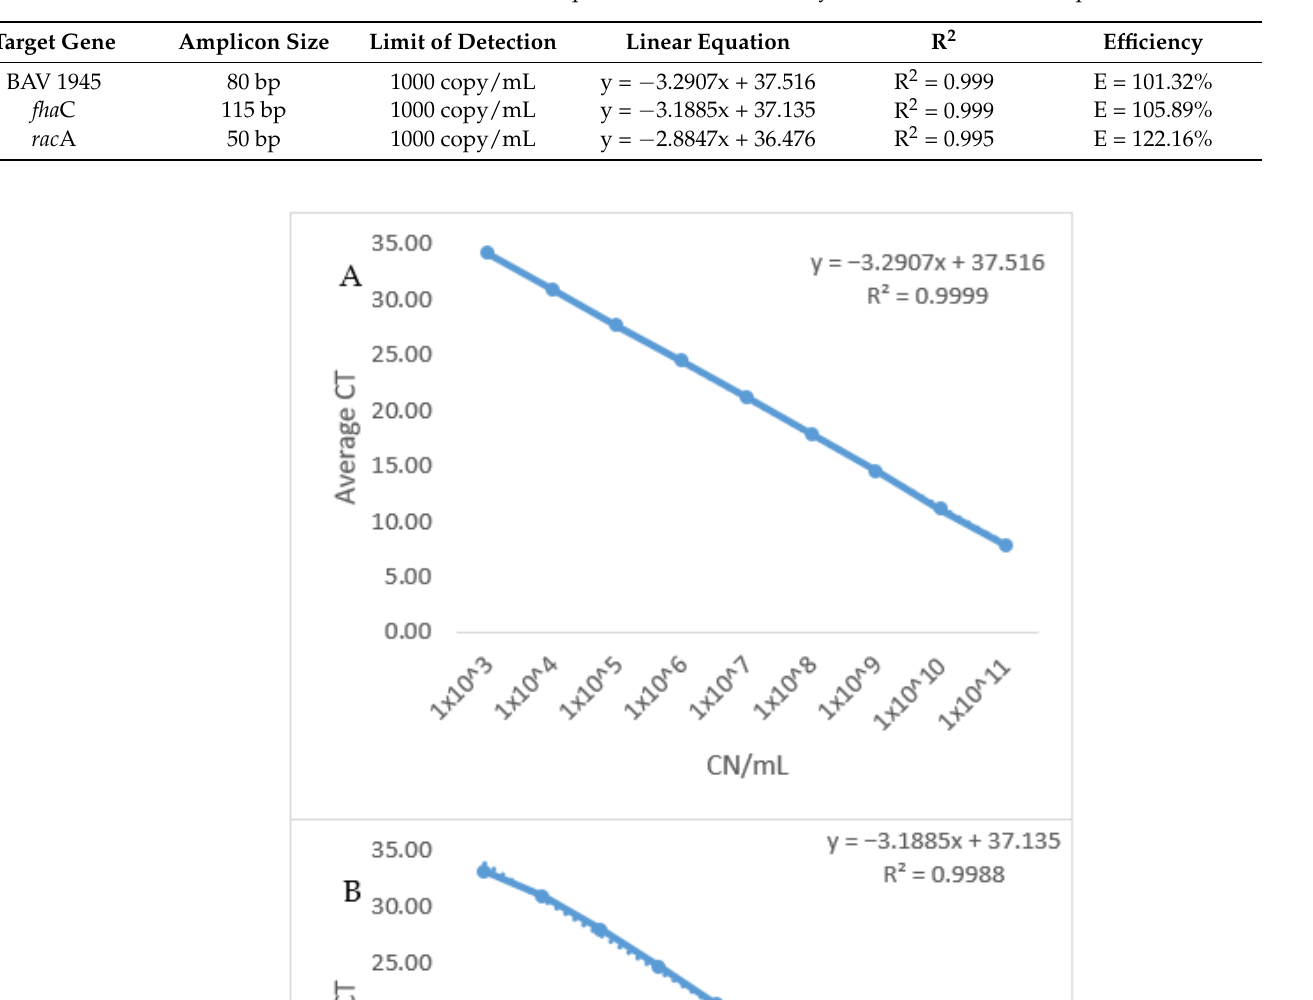
Table 4. Detection limits, standard curves linear equasions, R2 and Efficency and results of the three qPCRs.